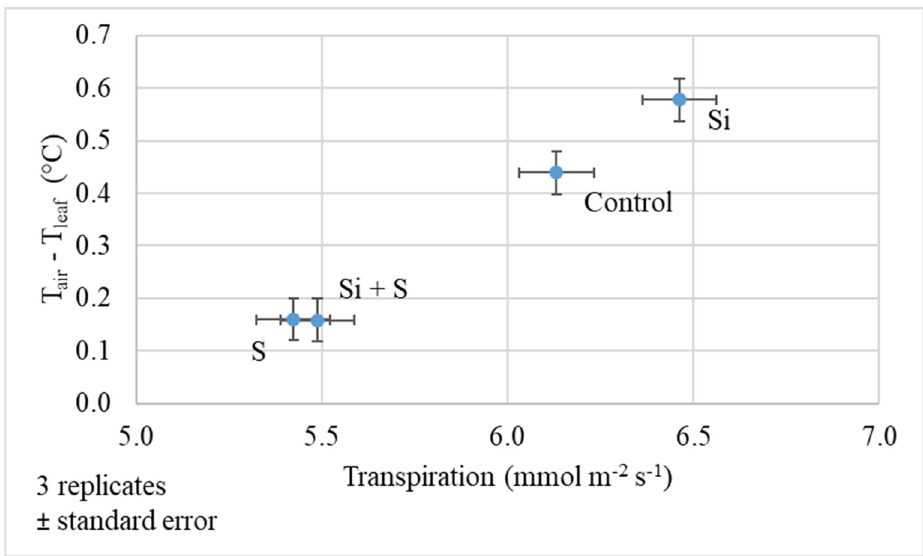
Figure 7. The difference in air and leaf temperature of oat as a function of transpiration (27 May, BBCH52); Means of the varieties, ± standard error.